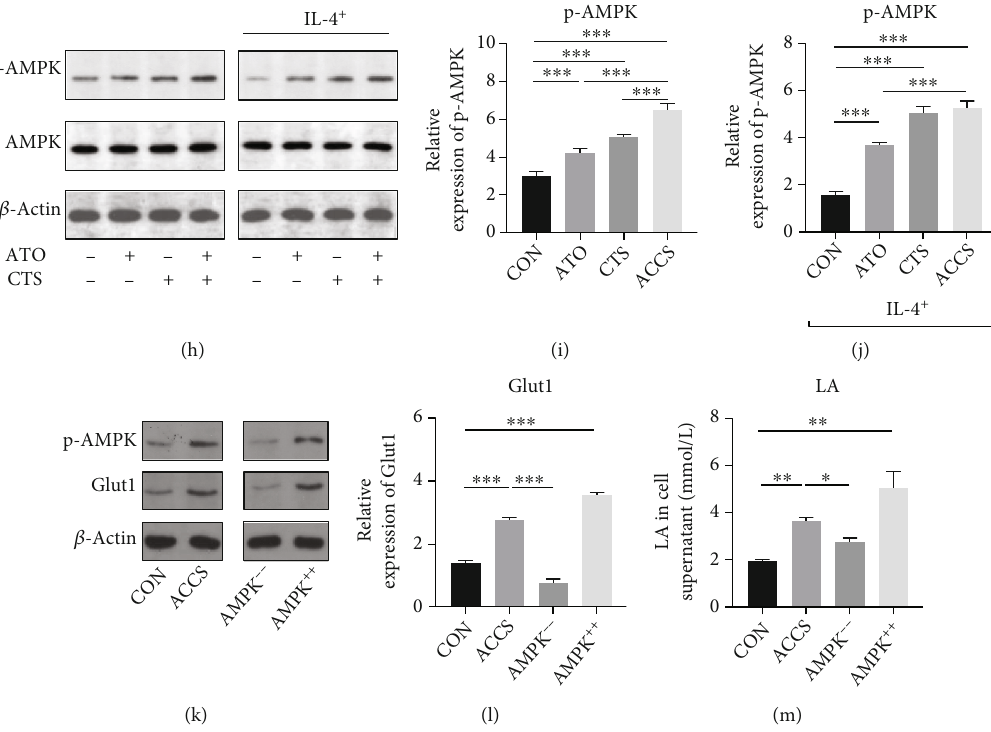
Figure 7: (a) Regulation of NF- κ B/HIF-1 α signaling pathway by ACCS. (b – d) Activation of NF- κ B/HIF-1 α signaling pathway after ACCS intervention in primary M0 macrophages. (e – g) Activation of NF- κ B/HIF-1 α signaling pathway after ACCS intervention in tumor-like M2- type macrophages. (h) Regulation of AMPK signaling pathway by ACCS. (i) Activation of the AMPK signaling pathway after ACCS intervention in primary M0 macrophages. (j) Activation of AMPK signaling pathway after ACCS intervention in tumor-like M2-type macrophages. (k – m) Expression of LA in supernatant and protein level of Glut1 after AMPK blockade and